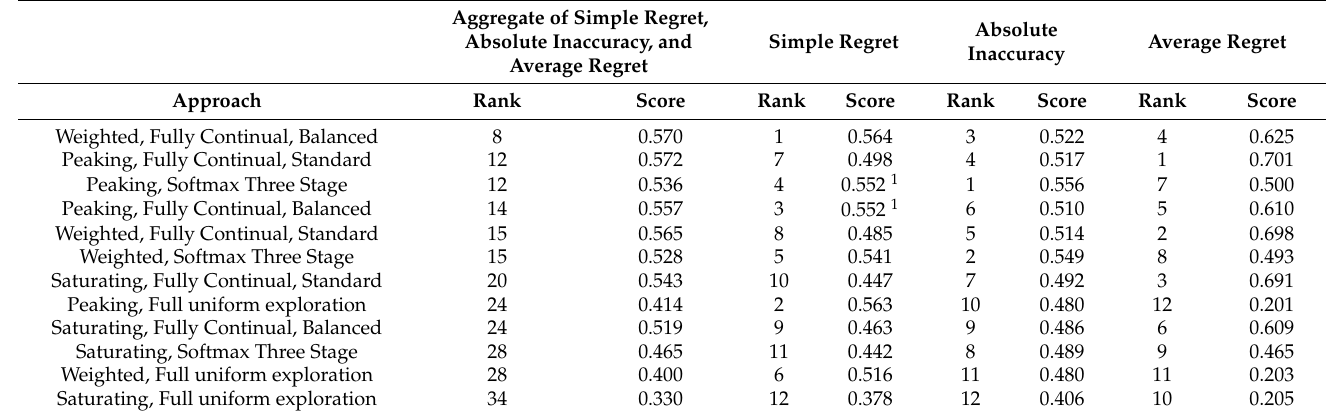
Table 3. Copeland scores and rankings for all approaches with a trial size of 30 across all scenarios. Ordering is by aggregate rank. Aggregate rank was calculated as the sum of ranks for simple regret, absolute inaccuracy, and average regret. Aggregate score was the mean of scores for simple regret, inaccuracy, and average